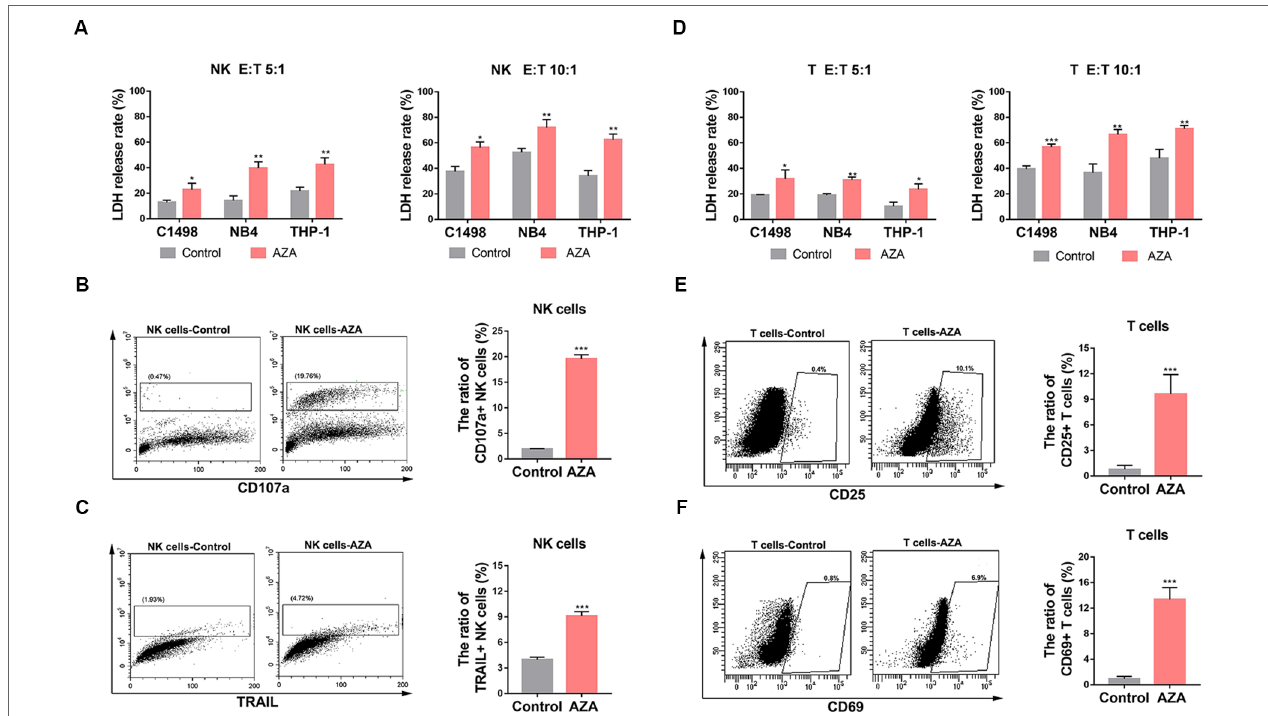
FIgUrE 3 | Azelaic acid (AZA) promotes the activation of NK and T cells and enhances cytotoxicity against acute myeloid leukemia (AML) cells. (A, D) NK and T cells were treated with 10 μM AZA for 48 h before incubation with AML cell lines at different E:T ratio for the cytotoxicity assay (E:T = 5:1 and 10:1). Cytotoxicity was measured by an LDH assay. (B , c) NK cells were treated with 10 μM AZA for 48 h before incubation with the AML cell lines at an E:T ratio of 3:1. Cells were then stained with CD107a and TRAIL for flow cytometric analysis. Right, the percentage of positive staining cells. (E, F) T cells were treated with 10 μM AZA for 48 h before incubation with the AML cell lines at an E:T ratio of 3:1. Cells were then stained with CD25 and CD69 for flow cytometric analysis. Right, the percentage of positive staining cells. A total of three independent experiments were performed, diagrams represents mean percentage, statistical significance was determined